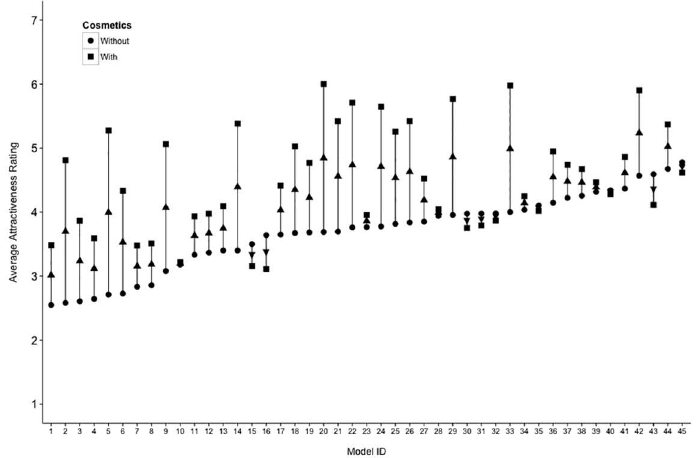
Fig 4. An illustration of the average attractiveness (combining ratings made by men and women) of each model, both without cosmetics and with cosmetics. Models are ordered in terms of increasing attractiveness without cosmetics. An upward pointingarrow indicates an increase in attractiveness with cosmetics, while a downwardarrow indicatesa decrease.